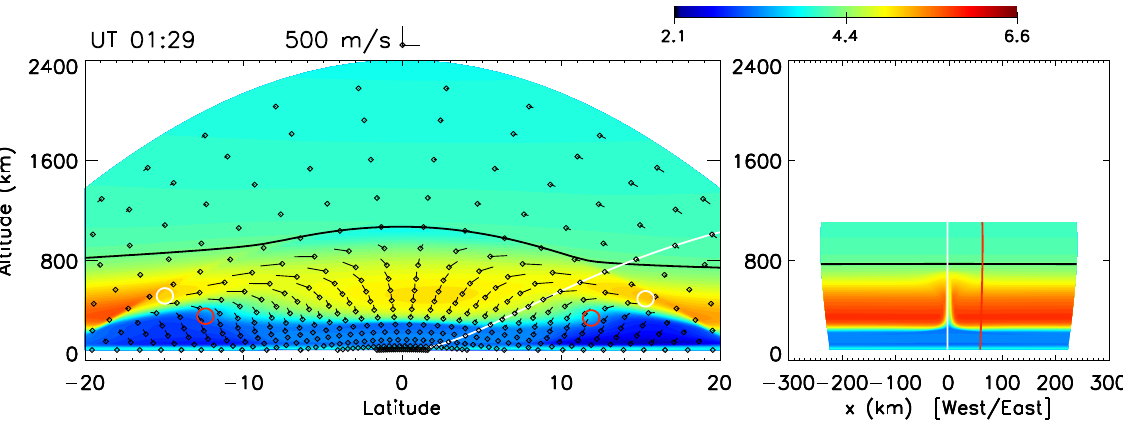
Fig. 6. Contours of log 10 n e at a fixed longitude (left) and in a surface that slices through the northern “leg” of the ESF plume (right). The location of the left-hand contour in the right-hand panel is indicated by a white line and vice versa. Ionization crests are indicated within the ESF plume (white circles) and in the background (red circles). A dark curve near the center of each plot indicates the H + /O + transition height. In the left hand panel, O + ion velocity vectors indicate the direction of flow away from the dot.